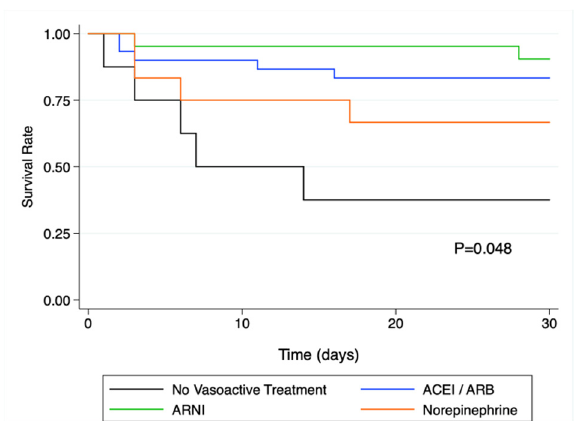
Figure 2. Kaplan-Meier survival analysis at 30 days in the different vasoactive treatment sub- groups. There was a significant difference in survival as assessed by the log rank test ( p = 0.048), and survival was significantly altered in patients without vasoactive drugs prior to surgery. ACEi: angiotensin converting enzyme inhibitor; ARB: angiotensin receptor blocker; ARNi: angiotensin receptor-neprilysin inhibitors. Table 4. Multivariate regression analysis on factors associated with 30-day mortality.